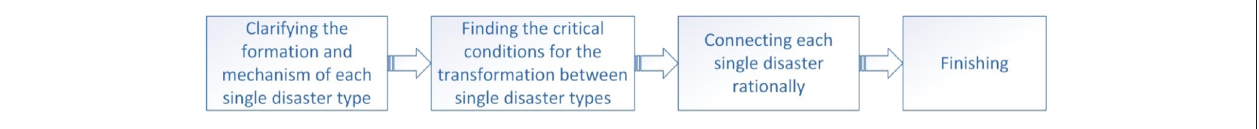
FIGURE 9 | Research ideas of the disaster